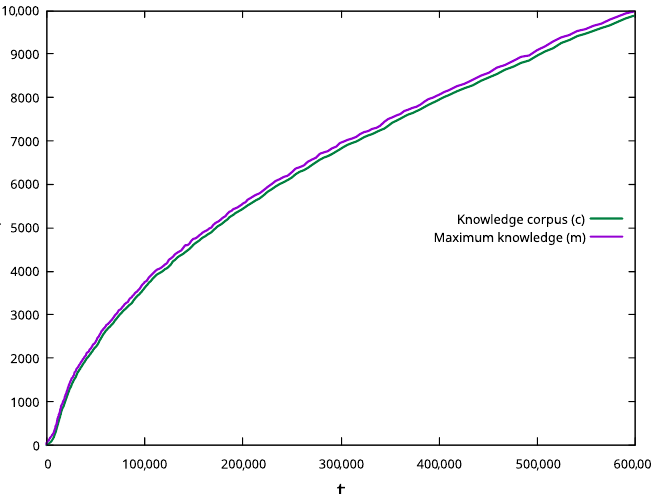
Figure 3. Comparison , between the evolution of the knowledge corpus ( c ) and maximum knowledge ( m ) vs. time for N = 10,000, K = 4 and L =